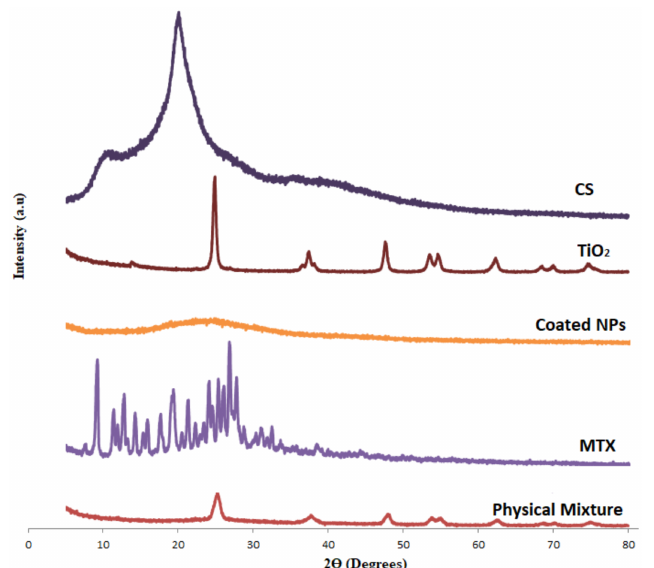
Figure 3. XRD of CS, MTX, TiO 2 NPs, the physical mixture (MTX-CS-NPs with TiO 2 NPs) and the coated MTX-CS-NPs with TiO 2